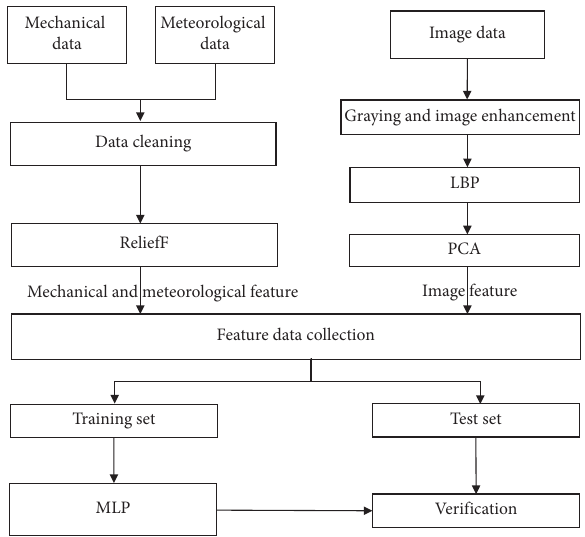
Figure 1: The flowchart of the LPR-MLP